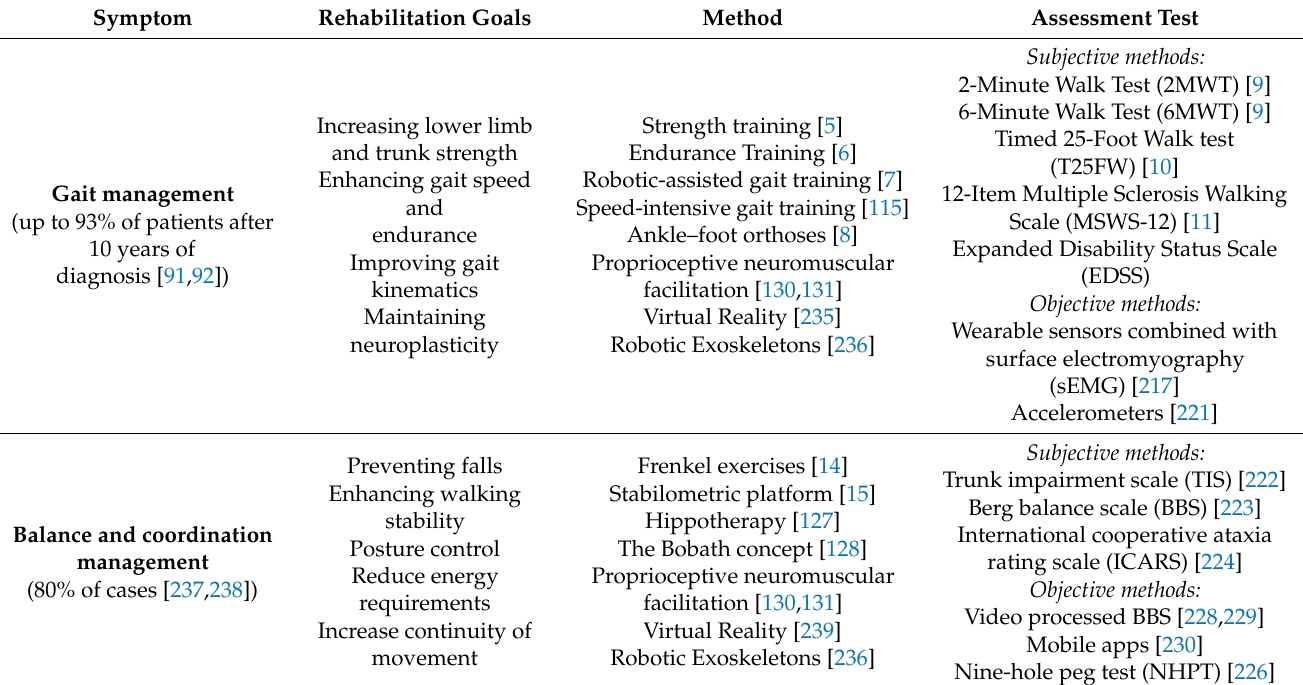
Table 1. Neurorehabilitation for the most common symptoms in multiple